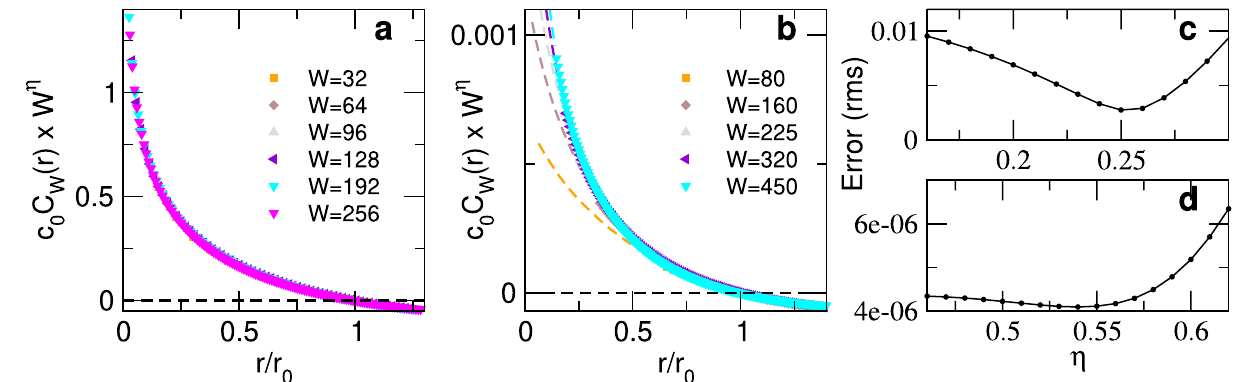
Figure 5. Correlation collapse after rescaling for the ferromagnetic 2D Ising and the neuronal model at criticality. Panel ( a ) 2D Ising model rescaled CCF as a function of W with fixed L (same same data as in Fig. 3e, with L = 600 , W < L , T = 2.27 ), collapsed as c 0 C W ( r ) × W η v.s. r / r 0 , with η = 0.25 . Panel ( b ) Collapse for neuronal model, using exponent η = 0.54 . For each value of W , points with r < I are shown with a dashed line of the same color. Panels ( c , d ) relative collapse error as a function of critical exponent η for the Ising and the neuronal model, respectively. All simulation parameters are as in previous